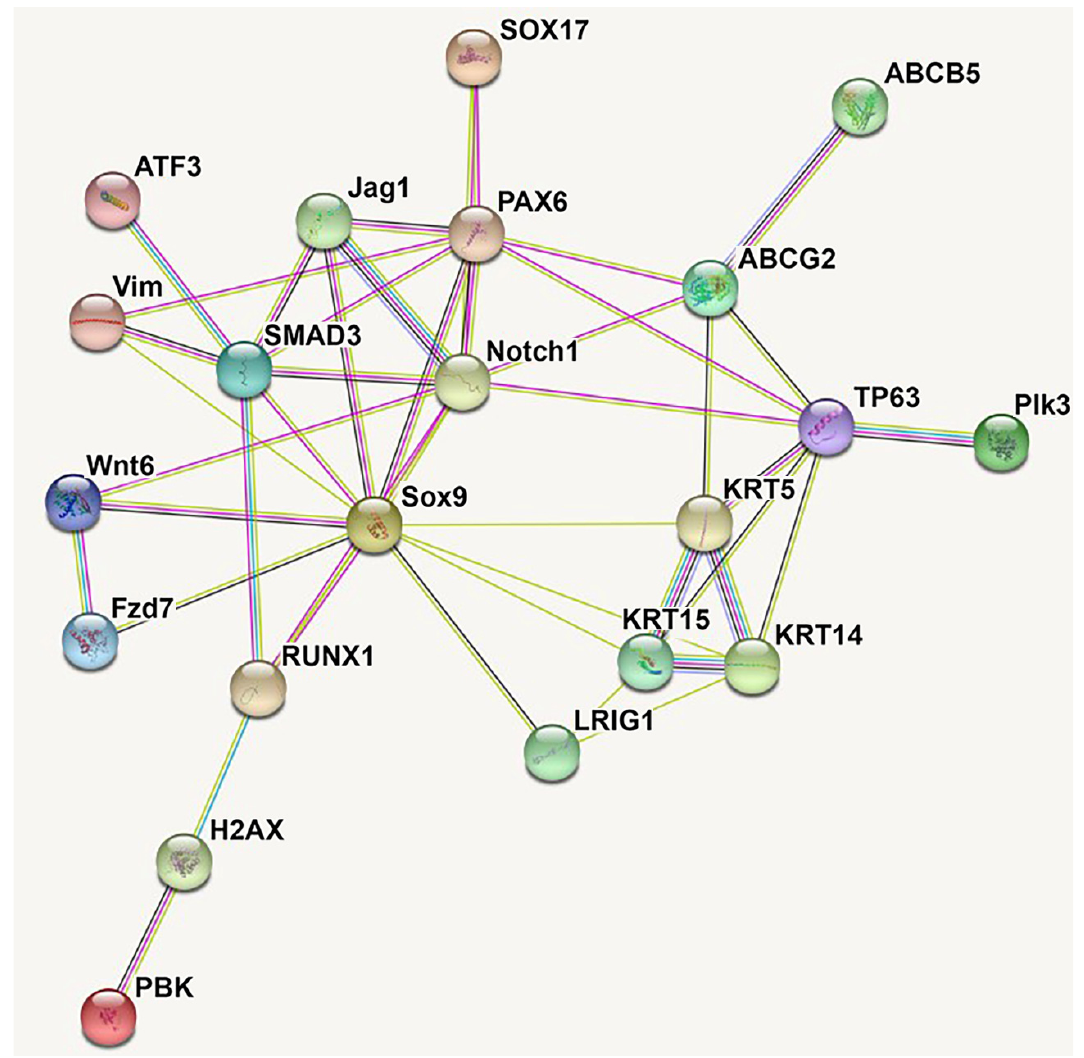
Figure 3. Protein-protein interaction networks of 21 LSC marker genes by STRING analysis. By direct/indirect interactions with other LSC molecular markers, transcription factor SOX9, SMAD3 and PAX6 work together with other stem cell proteins Notch1 and ABCG2, may act as master regulators mediating the proliferation and differentiation of LSC, which is crucial for eye development and corneal surface regeneration. Table 4. Genes and proteins implicated in LSC and niche